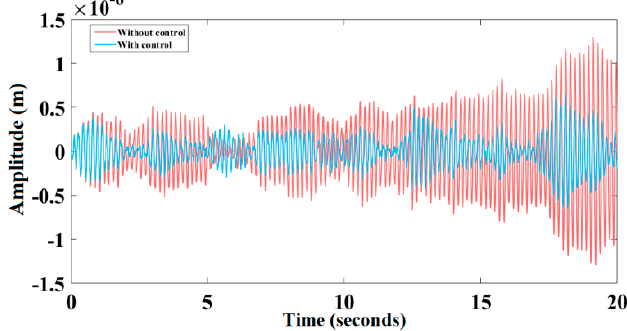
Figure 11. Impulse response of the beam (Sensors in FE3, Q = 10 10 , R = 1, Gc = 100). Figure 12. Impulse response of the beam (Sensors in FE3, Q = 10 12 , R = 1, Gc = 100).